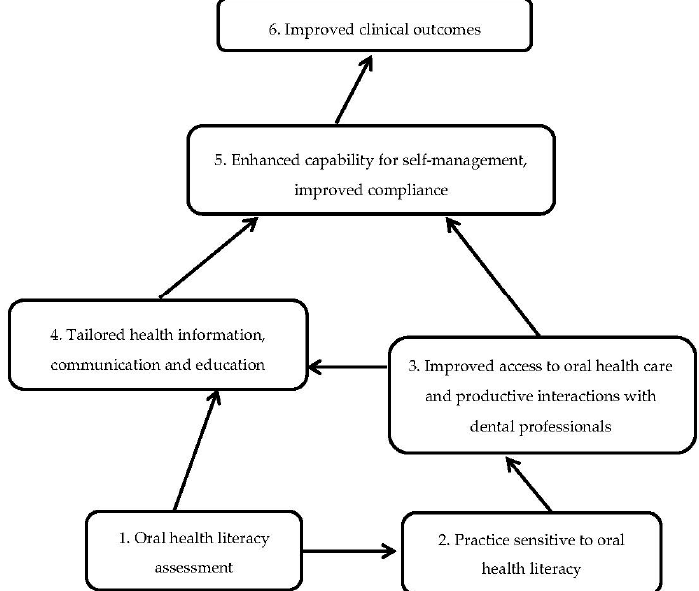
Figure 1. Model for the study adapted to oral health literacy from the Conceptual model of health literacy as a risk, proposed by Nutbeam [13].